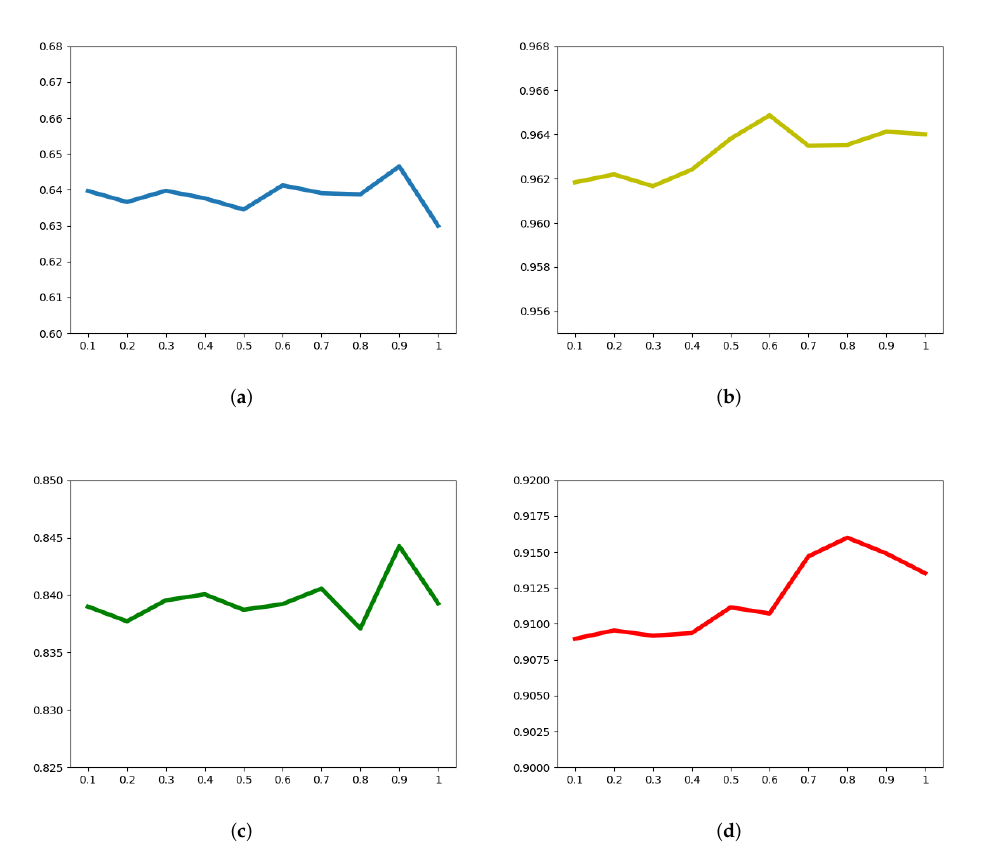
Figure 6. Weighted F1 values with different λ on four datasets. ( a ) HatEval, ( b ) Davids, ( c ) OffEval, ( d )